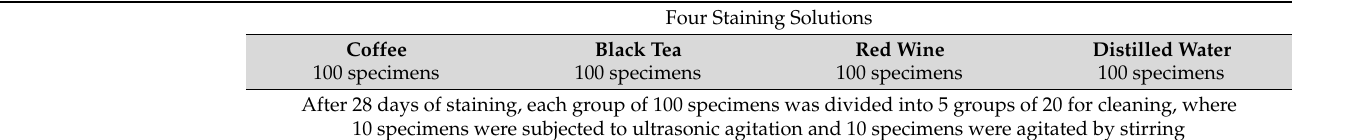
Table 1. The distribution of the specimens into staining groups and then, after staining, into clean- ing